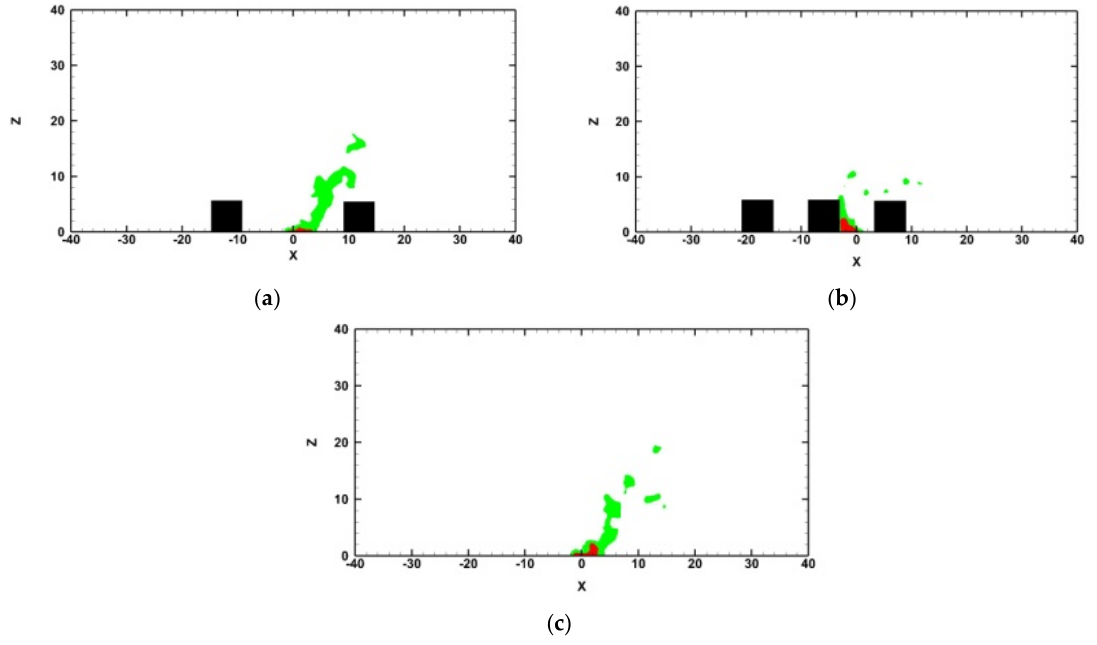
Figure 11. The LC1 zone and the IDLH zone at the fire’s symmetry for ( a ) Case 1; ( b ) Case 2; ( c ) Case 3 after 200 s of the fire incidence at the.